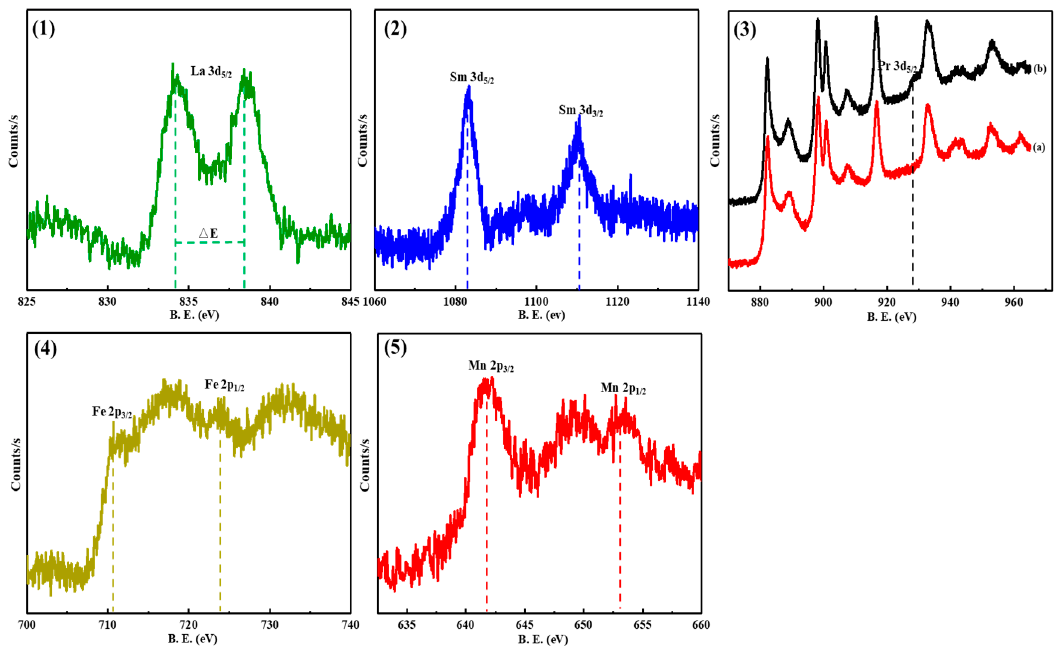
Figure 8. XPS profiles of La 3d ( 1 ), Sm 3d ( 2 ), Pr 3d ( 3 ), Fe 2p ( 4 ) and Mn 2p ( 5 ) over the 15CuO-3MO x /M-Ce80Zr20 (MO x = La 2 O 3 , Fe 2 O 3 , PrO 2 , Sm 2 O 3 , MnO 2 ) catalysts.